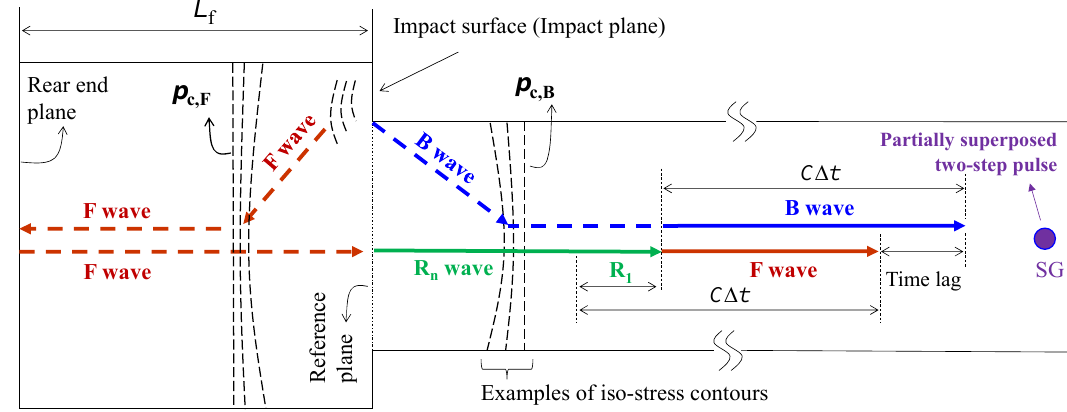
Figure 6. B, F, and R n waves when the flange length is intermediate (~ D b < L f < L s ). The critical plane for the F wave ( p c,F ) is positioned in the flange structure as L f , which in this case, is also sufficiently long.